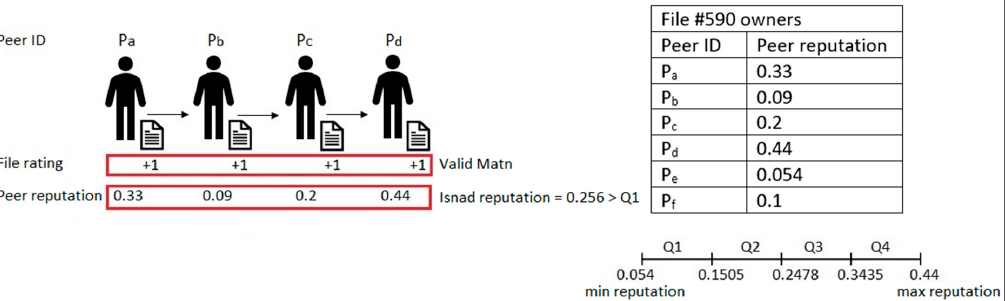
Figure 4. Authentic Isnad.